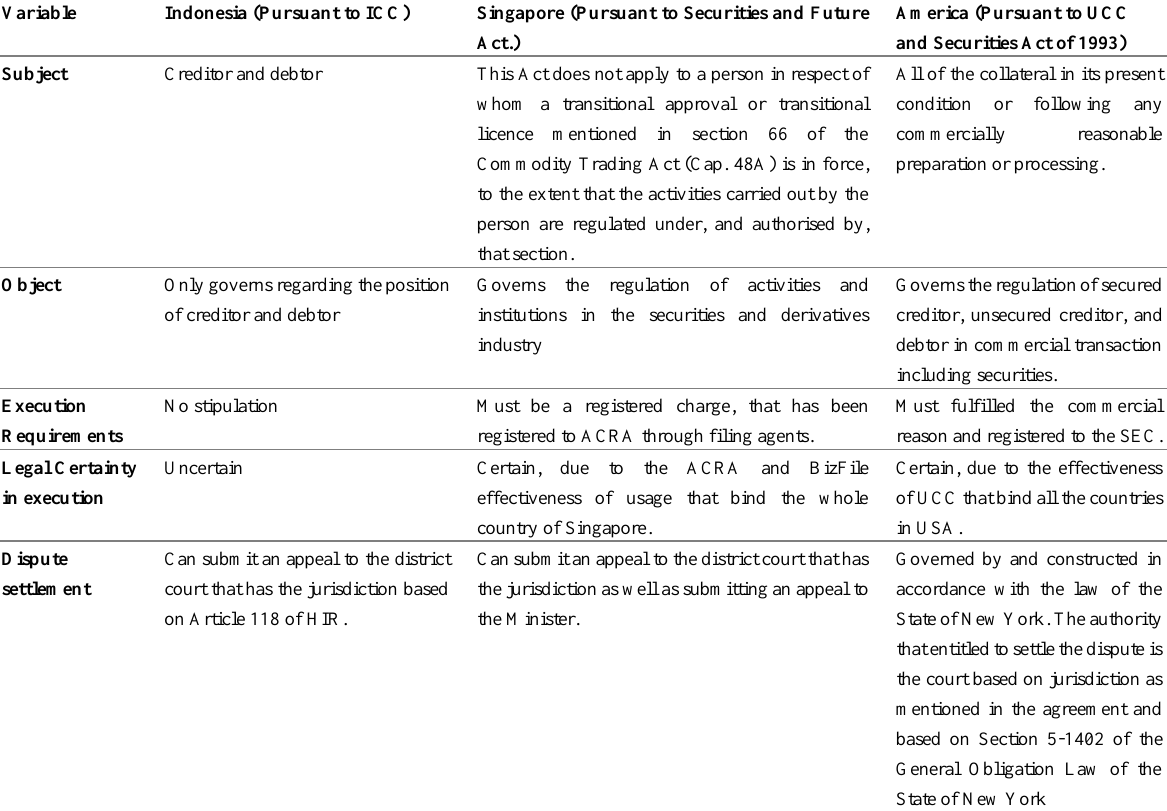
Table 1: Comparison of Landscape of Regulations in Indonesia, Singapore and